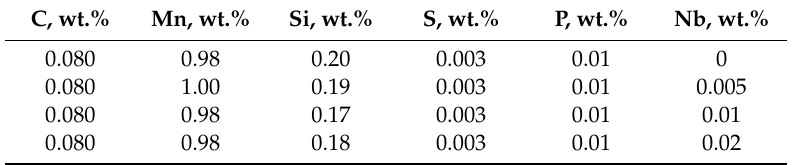
Table 1. Chemical composition of 0.08 wt.% carbon steel specimens (Weight Percent).